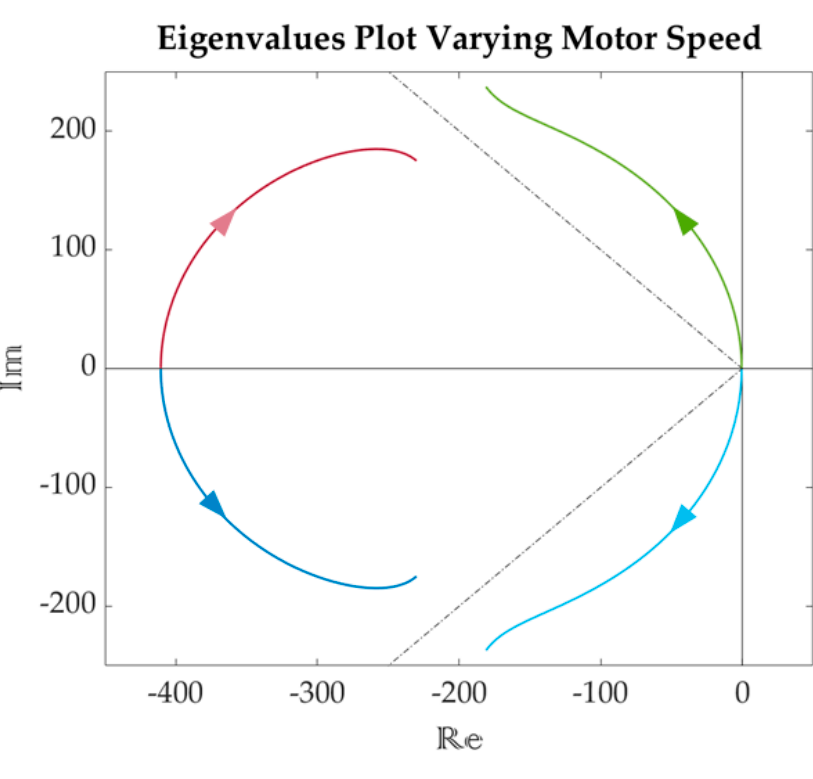
r K for 10 to − 10. Figure 3. Eigenvalues plot varying observer gains. Each color represents an eigenvalue that moves in the real–imaginary plane. Only eigenvalues on the left of the imaginary axis are represented. This shape is more or less constant for all the motors studied. Dashed axes represent the position of eigenvalues for which the system response has only one overshoot. The algorithm studied finds the Lu- enberger gains for which the eigenvalues are closest to the dashed axes. Four eigenvalues resulting from gains = and = -